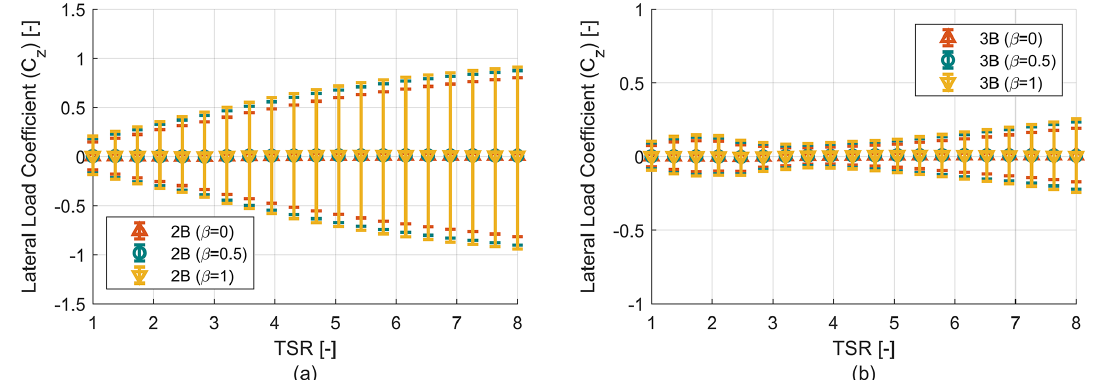
Figure 9. Rotor lateral load coefficient ( C z ) analysis. (a) Lateral load coefficient ( C z ) vs. TSR curve for two-bladed (2B) rotors. (b) Lateral load coefficient ( C z ) vs. TSR curve for three-bladed (3B) rotors.